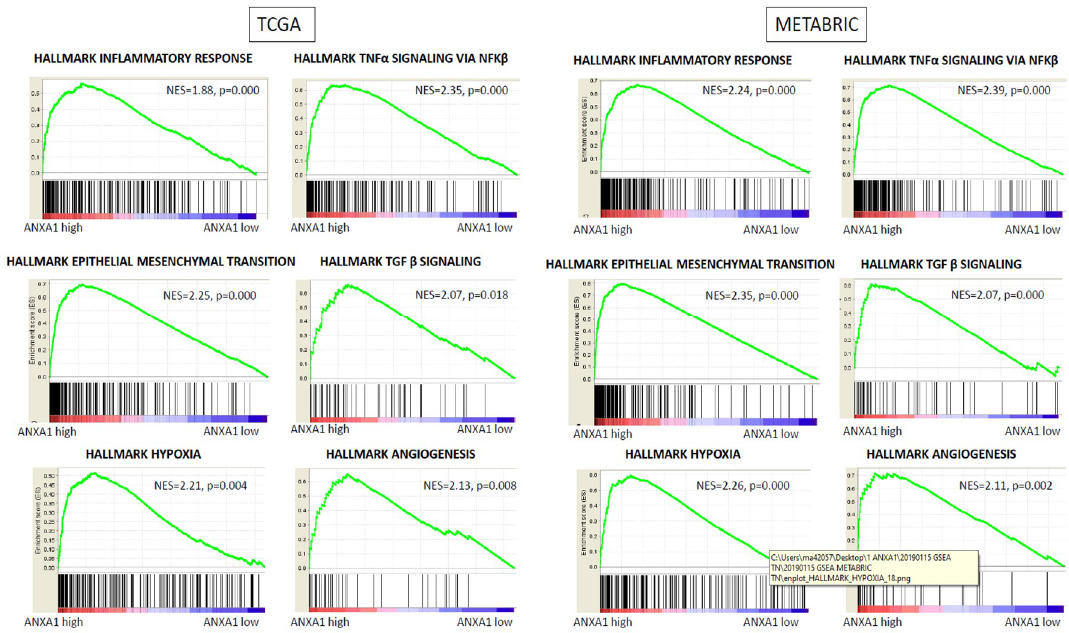
Figure 5. Gene set enrichment analysis (GSEA) showed that high ANXA1 expression tumors significantly enriched inflammatory response, TNF- α signaling via NF κ B, epithelial-mesenchymal transition, TGF- β signaling, hypoxia, and angiogenesis gene sets in TNBC in both TCGA and METABRIC cohorts.